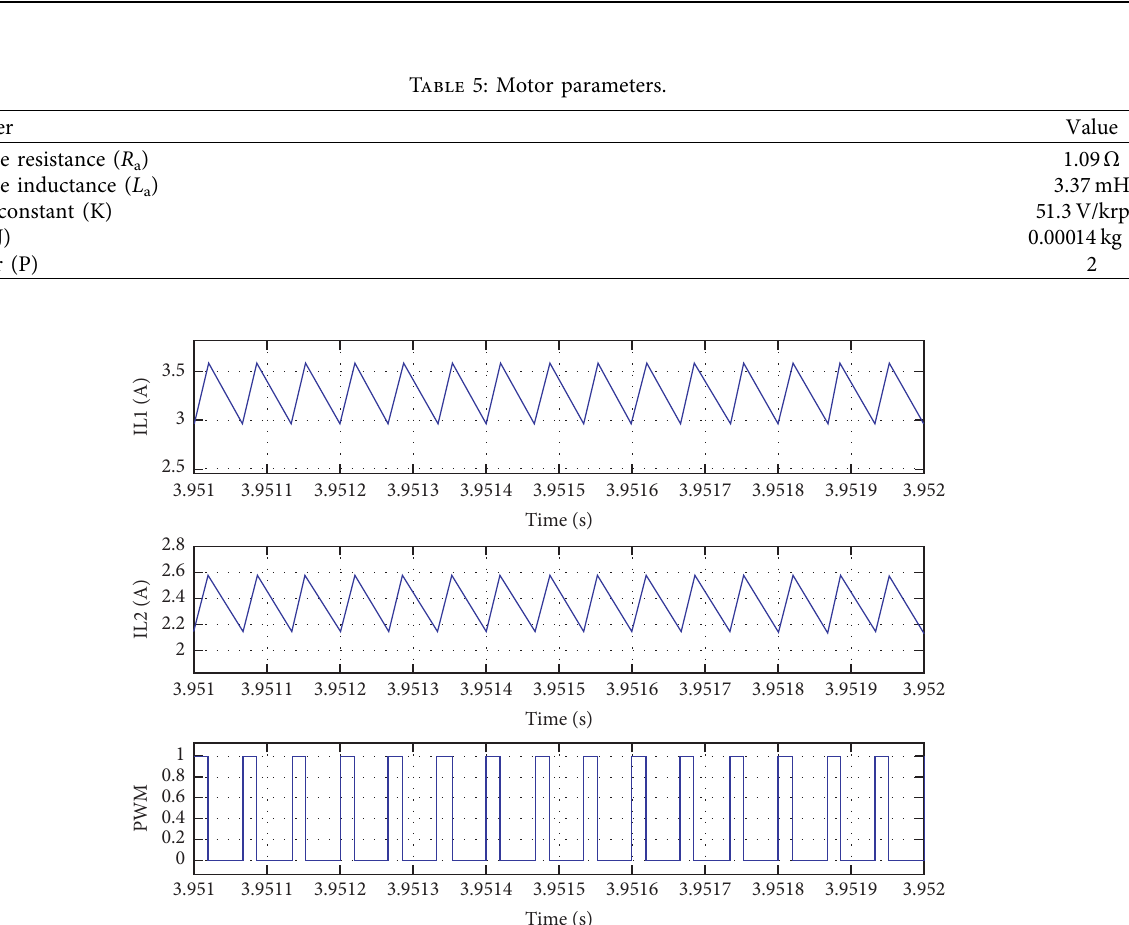
Figure 12: Inductor currents I L1 and I L2 with switching PWM during boost